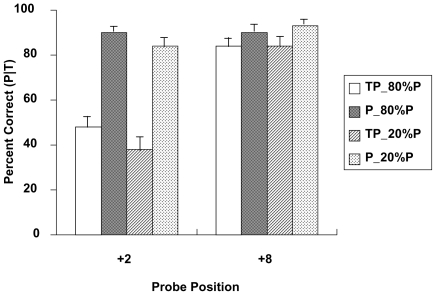
Probe detection accuracy as a function of the target presence, of the probe position, and of probe probability.Error bars represent +1 standard errors.